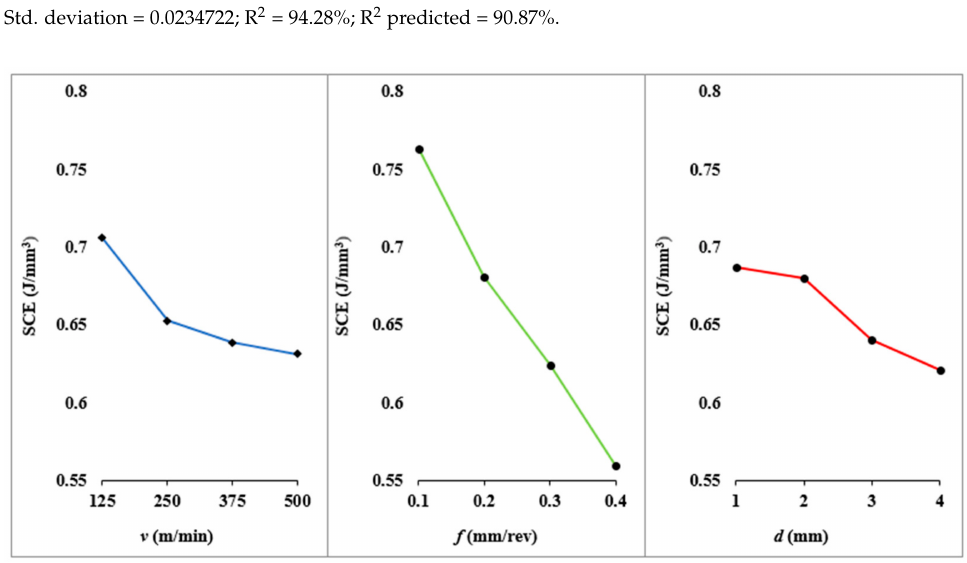
Figure 4. Main effect plot showing the influence of cutting parameters on SCE in